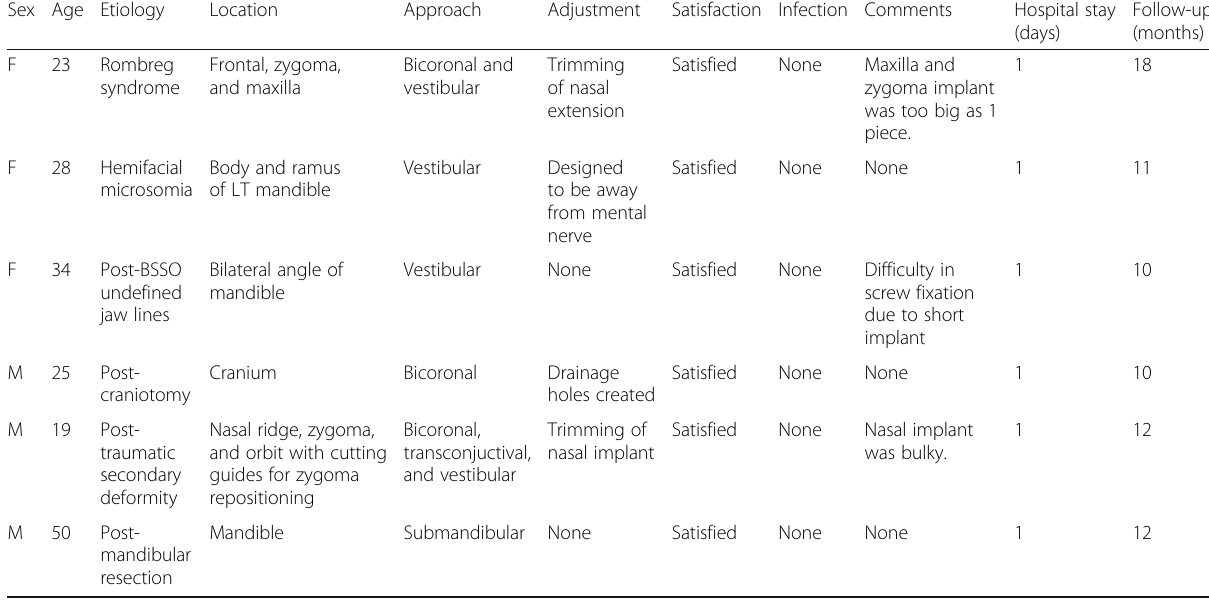
Table 1 Summary of all